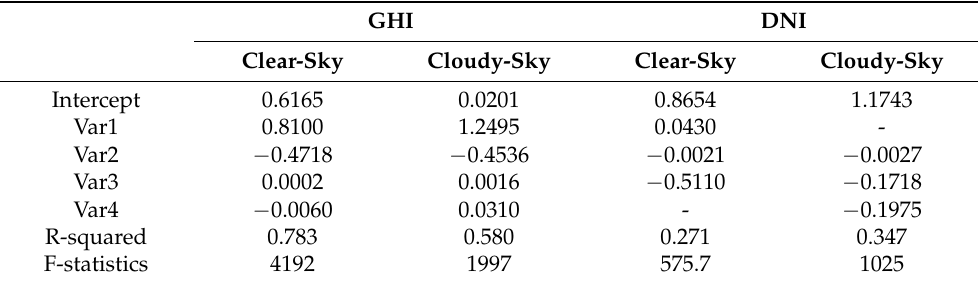
Table 3. Summary of MLR site-adaptation results for GHI and DNI under clear- and cloudy- sky